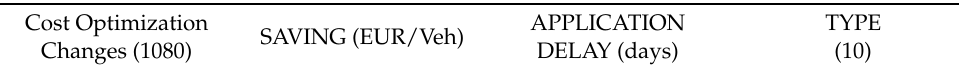
Table 5. Information for each cost reduction modification in